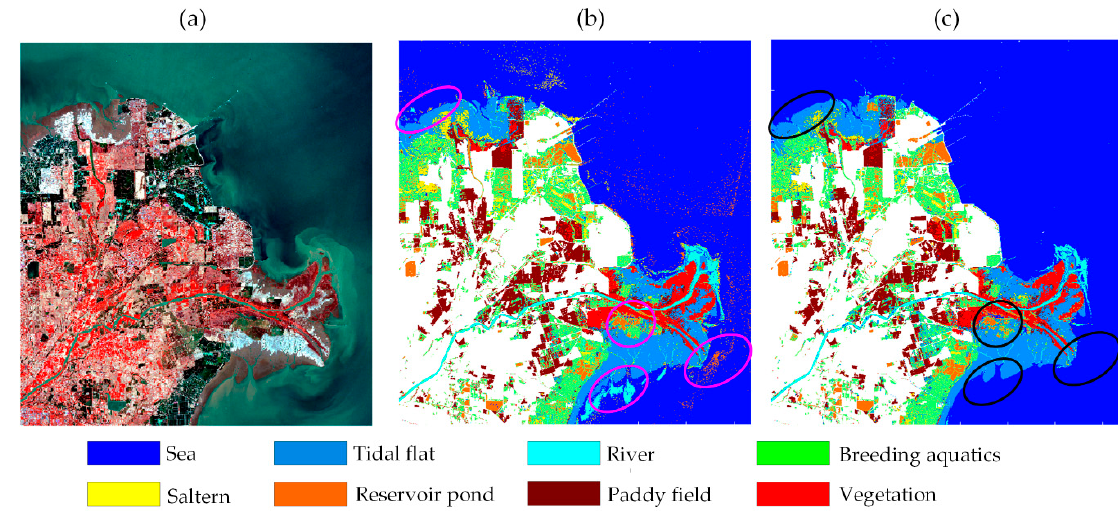
Figure 10. Classification results in Yellow River Delta (YRD) wetland, with ( a ) an image subset (NIR, G, and B bands only), ( b ) SCAA_MLP classification with spectral features, and ( c ) SCAA_MLP classification with spectral EMAP features.